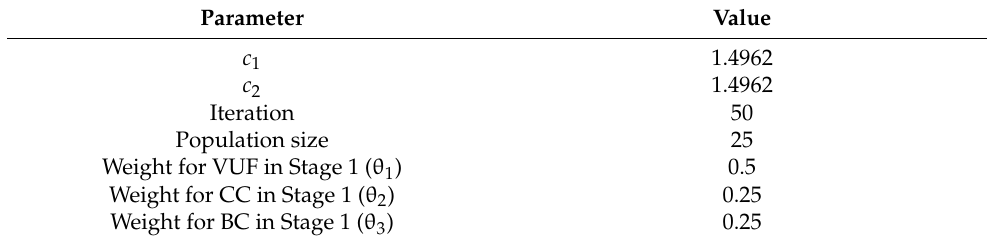
Table 4. Simulation parameters for PSO.